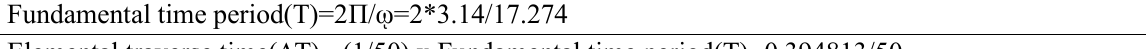
Calculation of Fundamental Time Period. Fundamental time